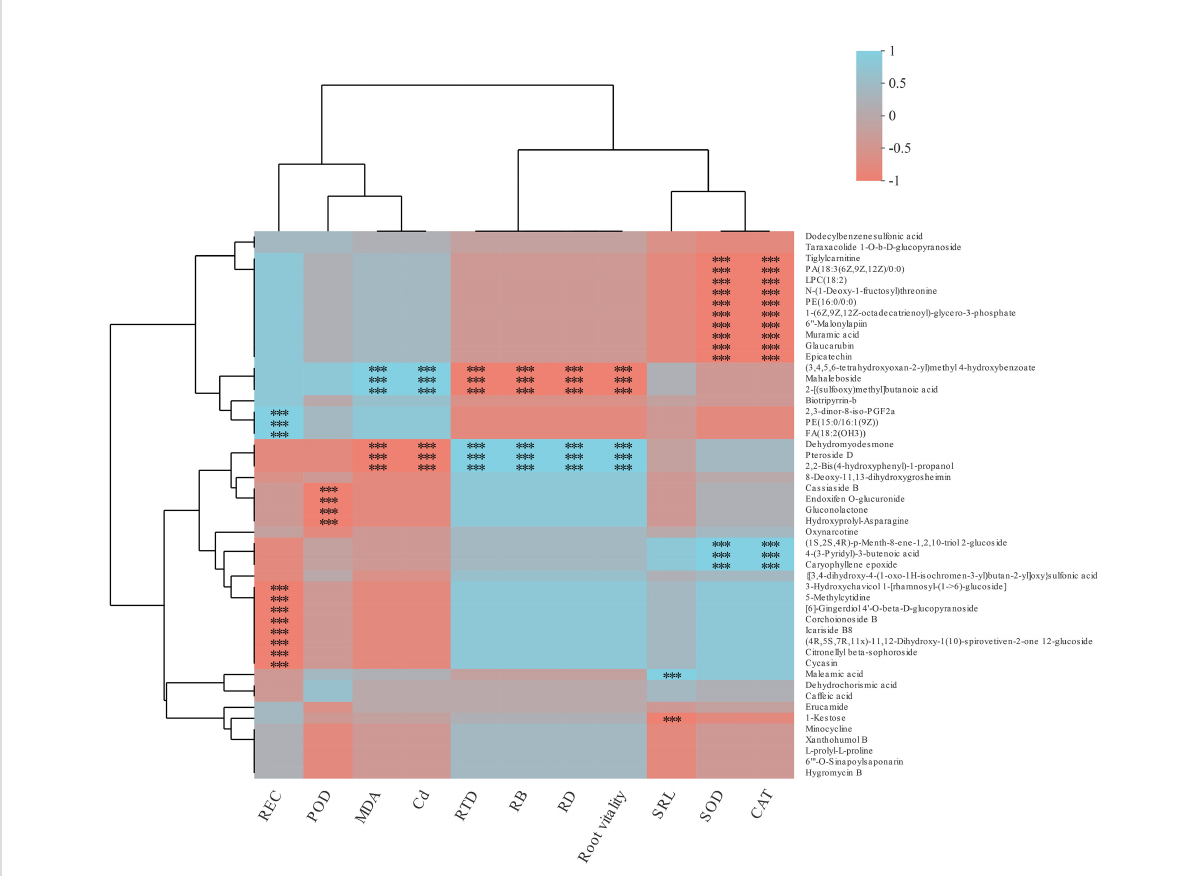
FIGURE 6 Primary metabolic fl ux map labeled with the differentially expressed metabolites of cotton lateral root. The data represents the ratio of the average expression of metabolites in the two groups of samples (Log2FC), with positive value indicating up-regulation and negative value indicating down-regulation. Solid arrows indicate direct action and dashed arrows indicate indirect action. Red represents Phenylalaninc metabolism; Green represents Ubiquinone and other terpenoid-quinone biosynthesis; Blue represents ABC